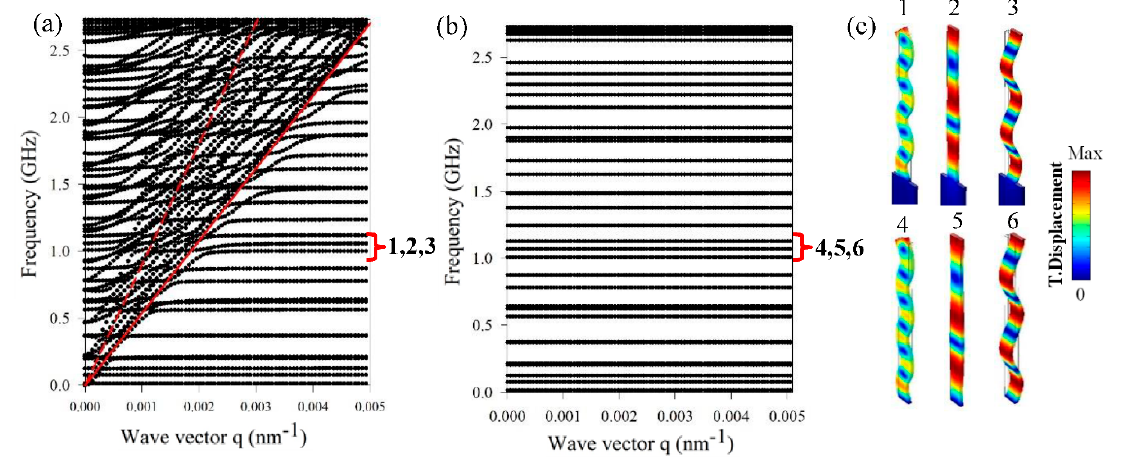
Figure 5. ( a ) Dispersion curves for the propagation perpendicular to the nanoridges for the set of geometrical parameters: a = 630 nm, h = 2.7 µm, and w = 250 nm; ( b ) Eigenfrequencies calculation of a single nanoridge with a rigid boundary condition at the bottom; ( c ) Representation of the displacement fields at the frequencies 1, 2, and 3 of the ridges deposited on a substrate, and for the frequencies 4, 5, and 6 of one ridge with a rigid bottom surface.